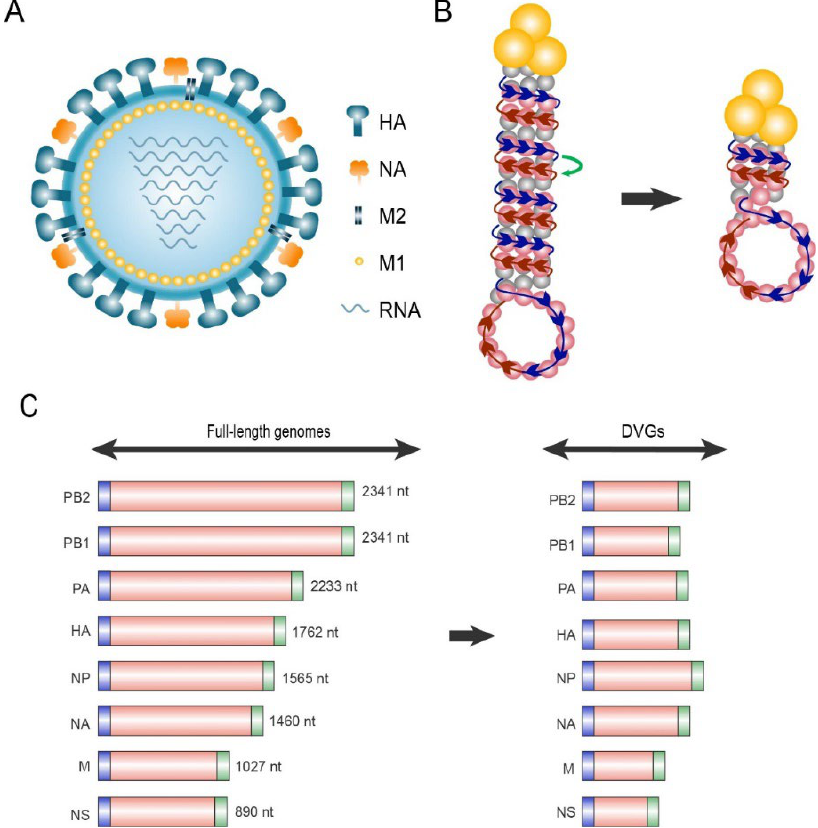
Figure 1. Schematic diagram of standard viruses (STV) and defective interfering particles (DIPs). ( A ) Schematic structure of the influenza A virus. ( B ) Mechanisms underlying the generation of influenza defective viral genomes (DVGs). The ribonucleoprotein consists of RNA-dependent RNA polymerase (RdRp, yellow trimer) and the single-stranded vRNA ( − ) genome coated with nucleoproteins. The RdRp, which originally synthesizes cRNA (+) along the vRNA ( − ) template (blue arrows) during replication, erroneously translocates to the adjacent antiparallel chain vRNA ( − ) (red arrow) in the RNP, causing large-scale deletion of the intermediate skipped sequences in DVGs. ( C ) Schematic length of full-length genomes and DVGs. Both full-length RNAs and DVGs contain 3′ (blue) and 5′ (green) terminal packaging signal sequences.